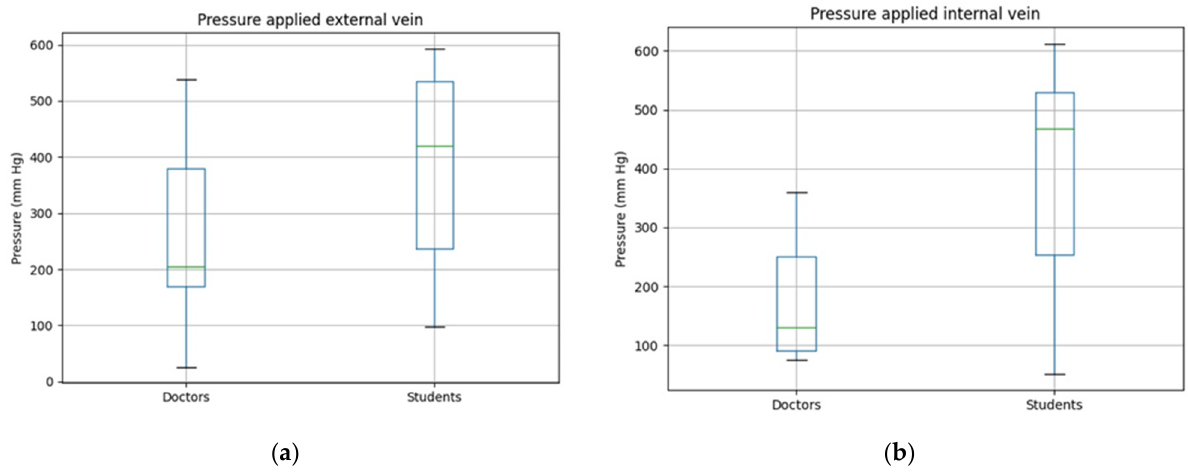
Figure 4. Pressure exerted to stop the bleeding by medical students and doctors if a venous bleeding occurs in the lower limb. ( a ) Pressure exerted to stop an external venous hemorrhage; ( b ) Pressure exerted to stop an internal venous hemor- rhage.